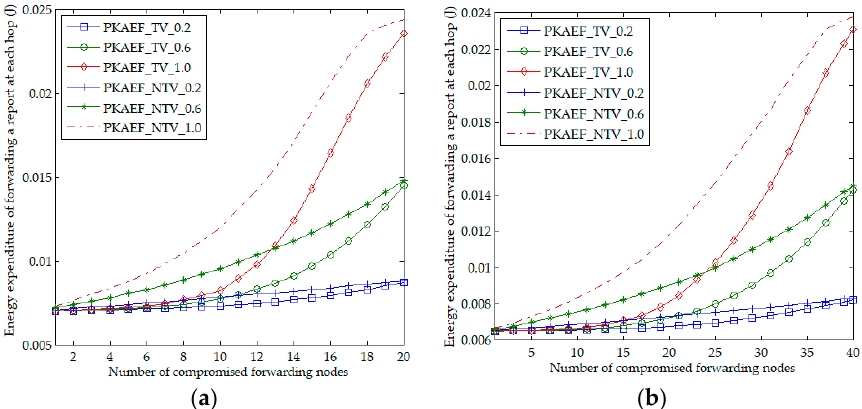
Figure 8. Energy expenditure for forwarding a report at each hop as a function of the number of compromised forwarding nodes. ( a ) in Scenario 1; ( b ) in Scenario 2.